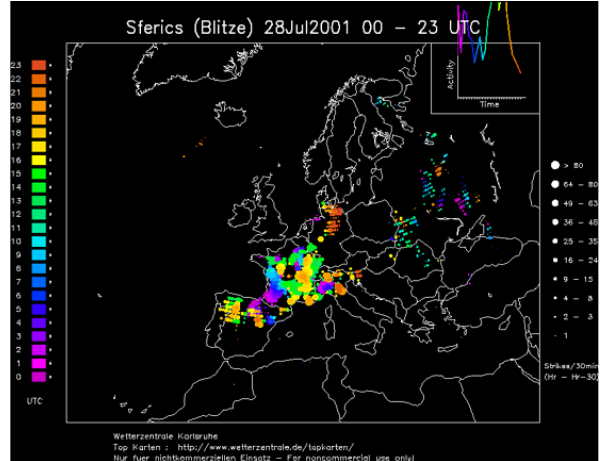
Fig. 9. Date: 28 July 2001, CL3. Spatial, temporal and intensity distribution of lightning